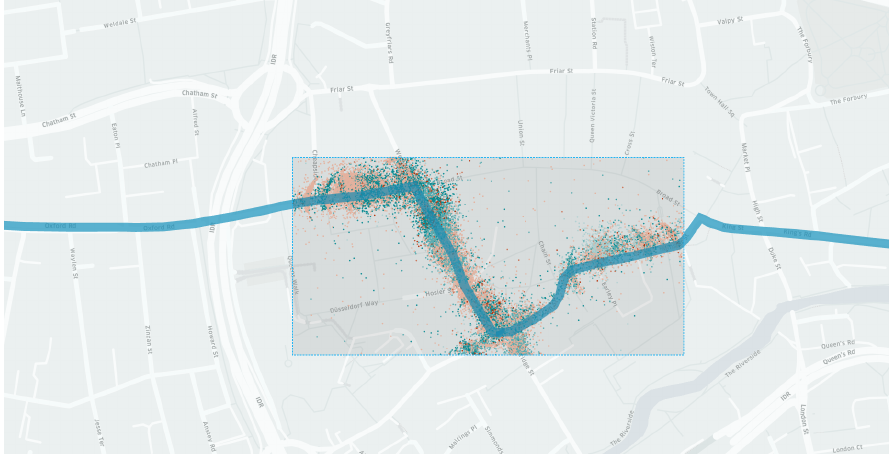
Figure 2. Map of the Reading city centre showing the route of the eastbound line 17 in blue with a square indicating the area of interest where the selection of additional lines to be included in the model was